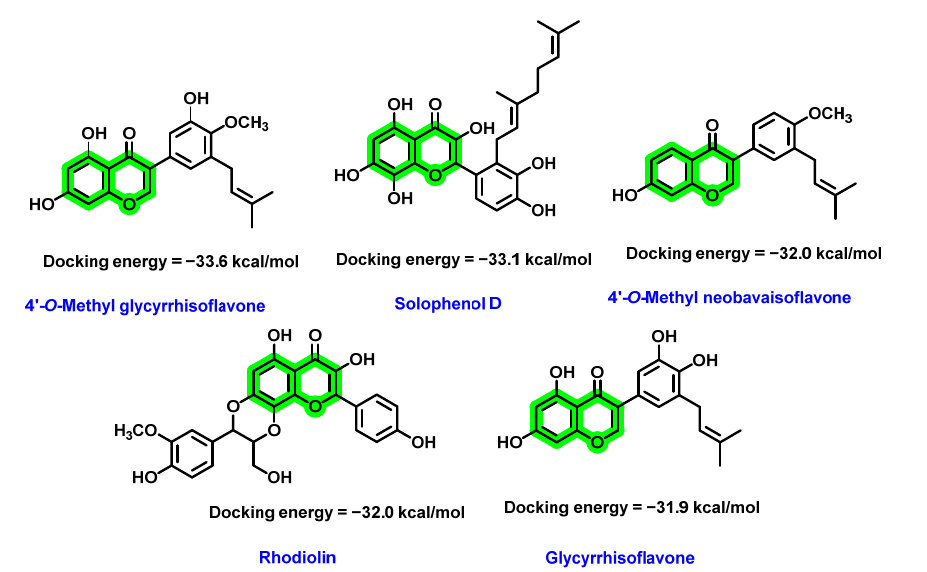
Figure 8. Docking of different flavonoids with DENV NS2B-NS3 protease with their docking score.